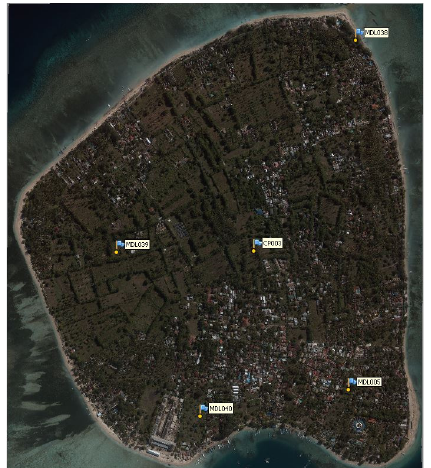
Figure 1. The area of study on Gili Air island, with the distribution of GCPs.